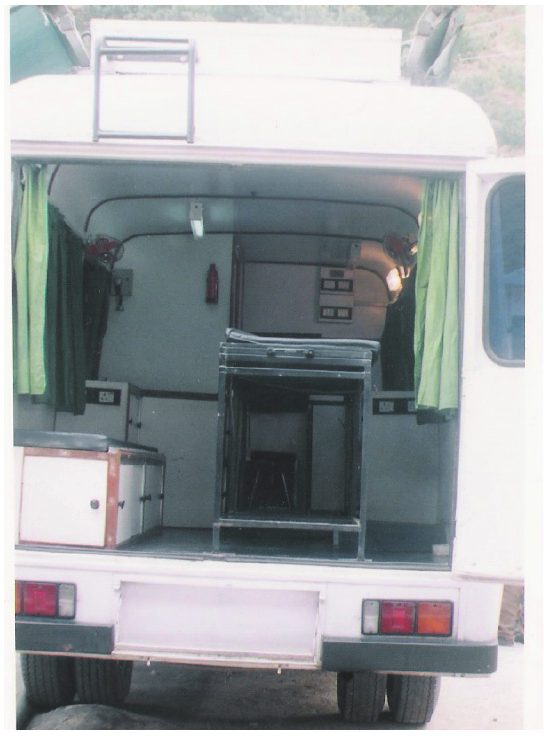
Figure 1 : Mobile operating van.